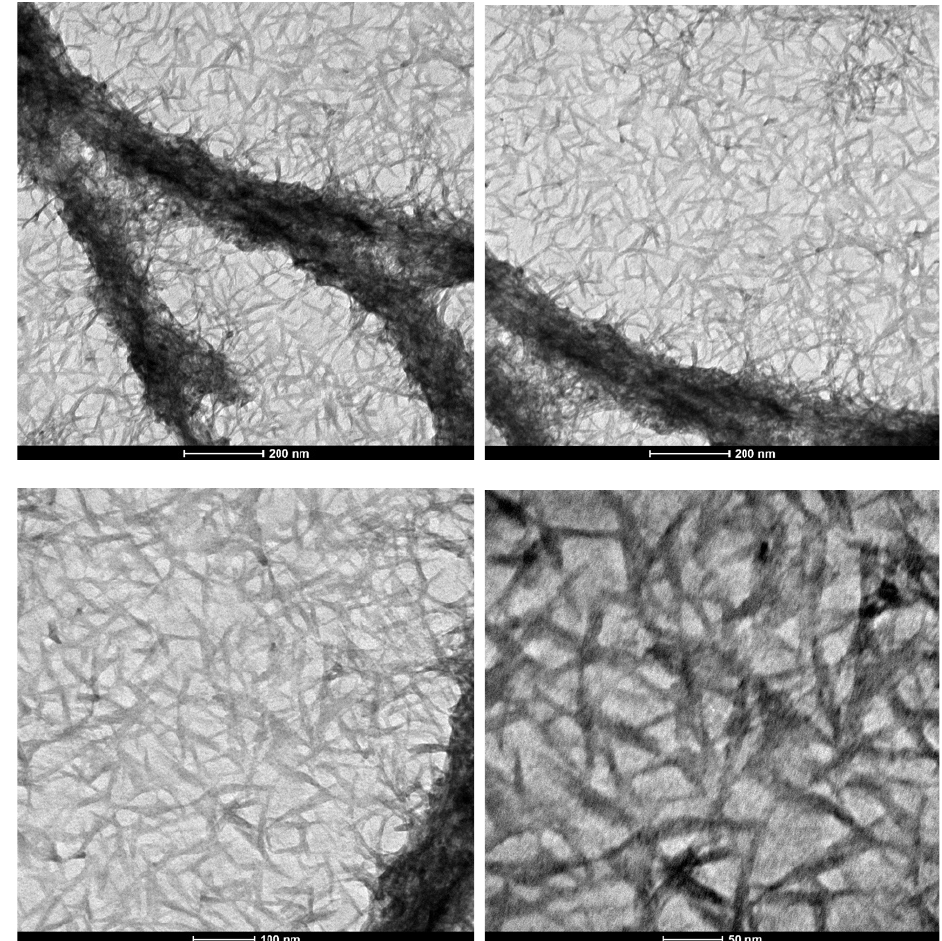
Figure 3. TEM images of amyloid fibrils at increasing magnifications.